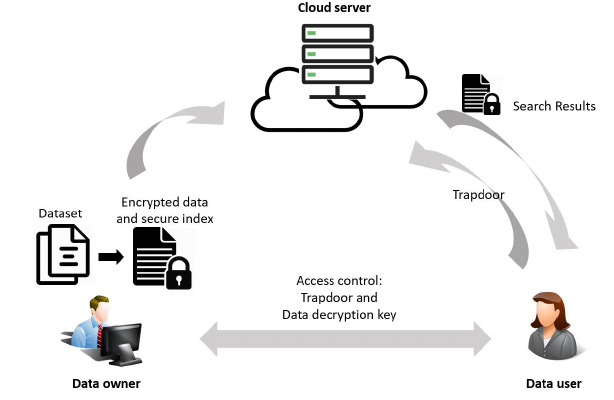
Figure 1. The architecture of our